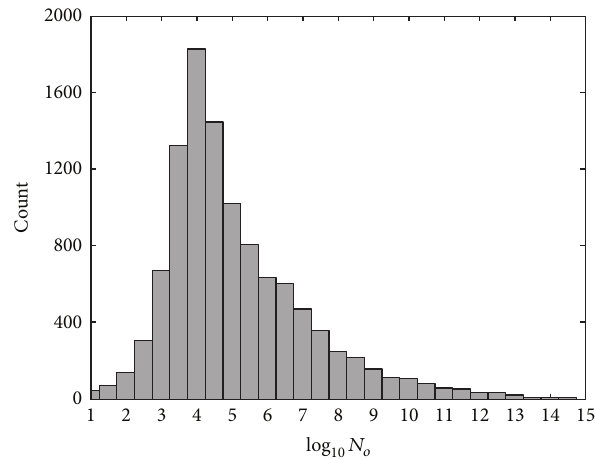
Figure 8: Histogram of estimated log 10 𝑁 𝑜 parameter for Gamma